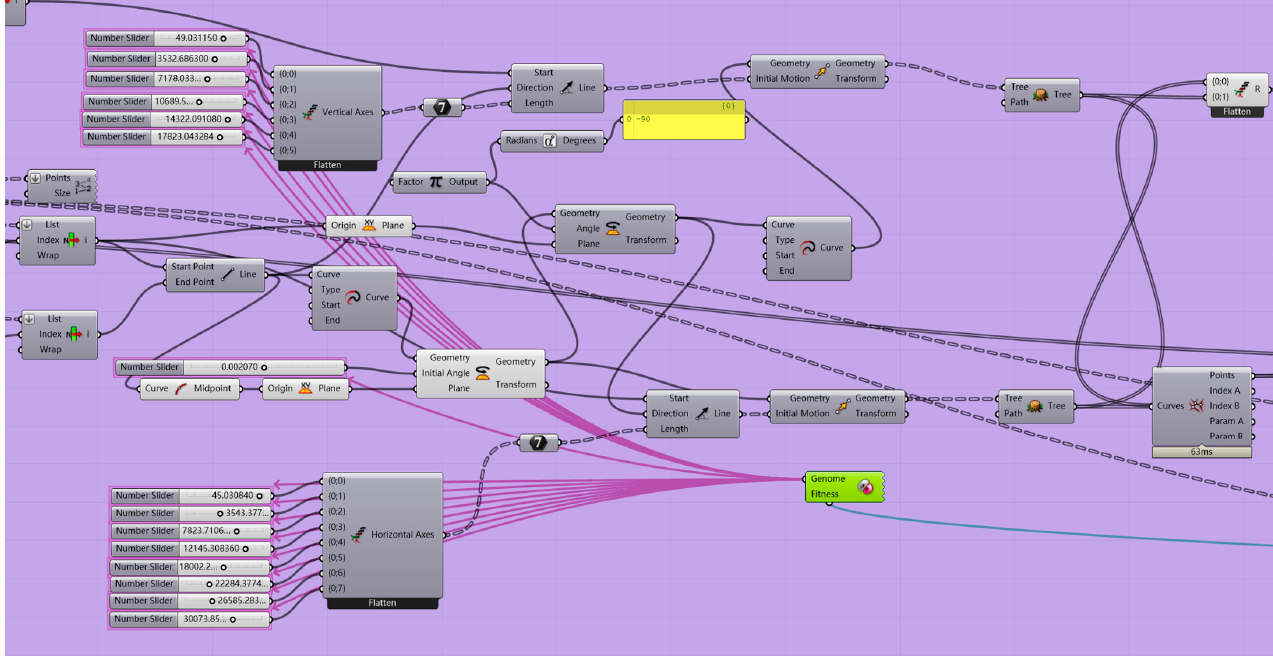
genetic algorithm solution.